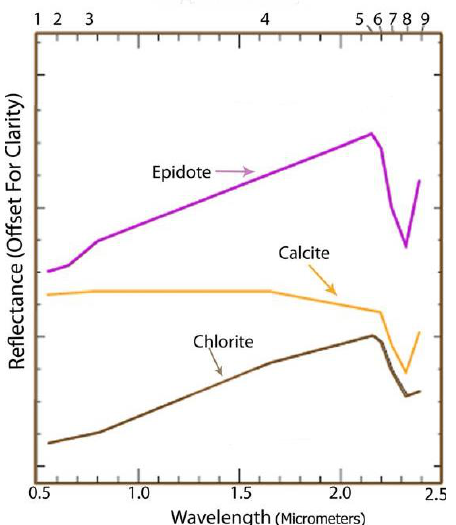
Figure 5. Laboratory spectra of epidote, calcite, and chlorite resampled to ASTER bandpasses. These minerals are typically associated with propylitic alteration and display 2.14-2.25 and 2.29-2.43 μm absorption features (Clark et al., 1993; Mars and Rowan,